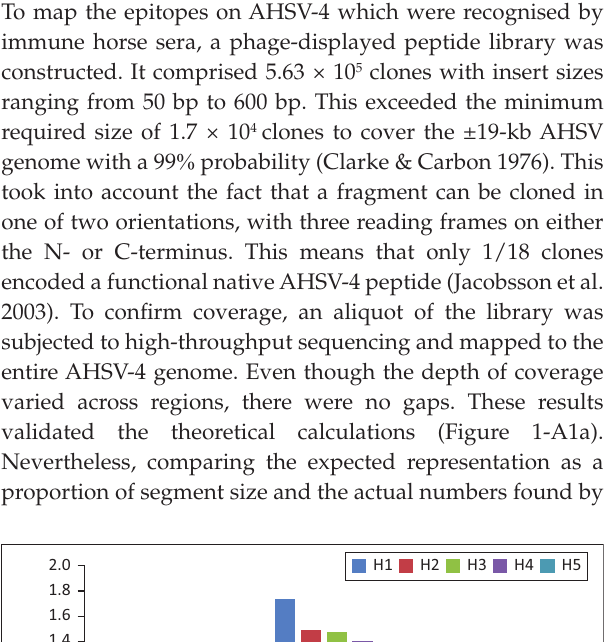
0.00.20.40.60.81.01.21.41.6 FIGURE 1: Enzyme-linked immunosorbent assay showing the antisera of the five horses (H1–5) collected pre-vaccination (day 0) and post-vaccination (day 28 and 52) reacting with purified African horse sickness virus-4. Each plotted value is an average of duplicate wells. Milk powder–negative control background signals were subtracted from the experimental